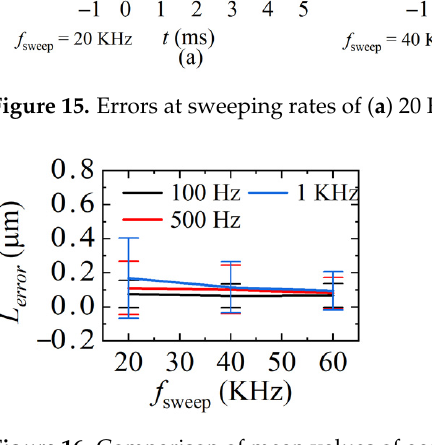
Figure 16. Comparison of mean values of gap measurement errors at different sweeping rates.